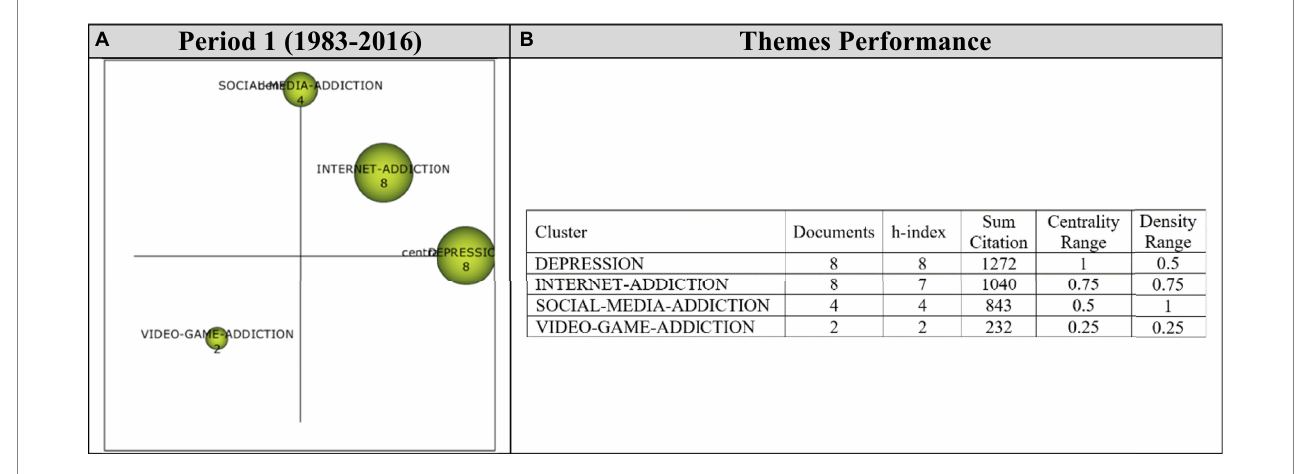
FIGURE 4 (A) Strategic diagram and (B) performance